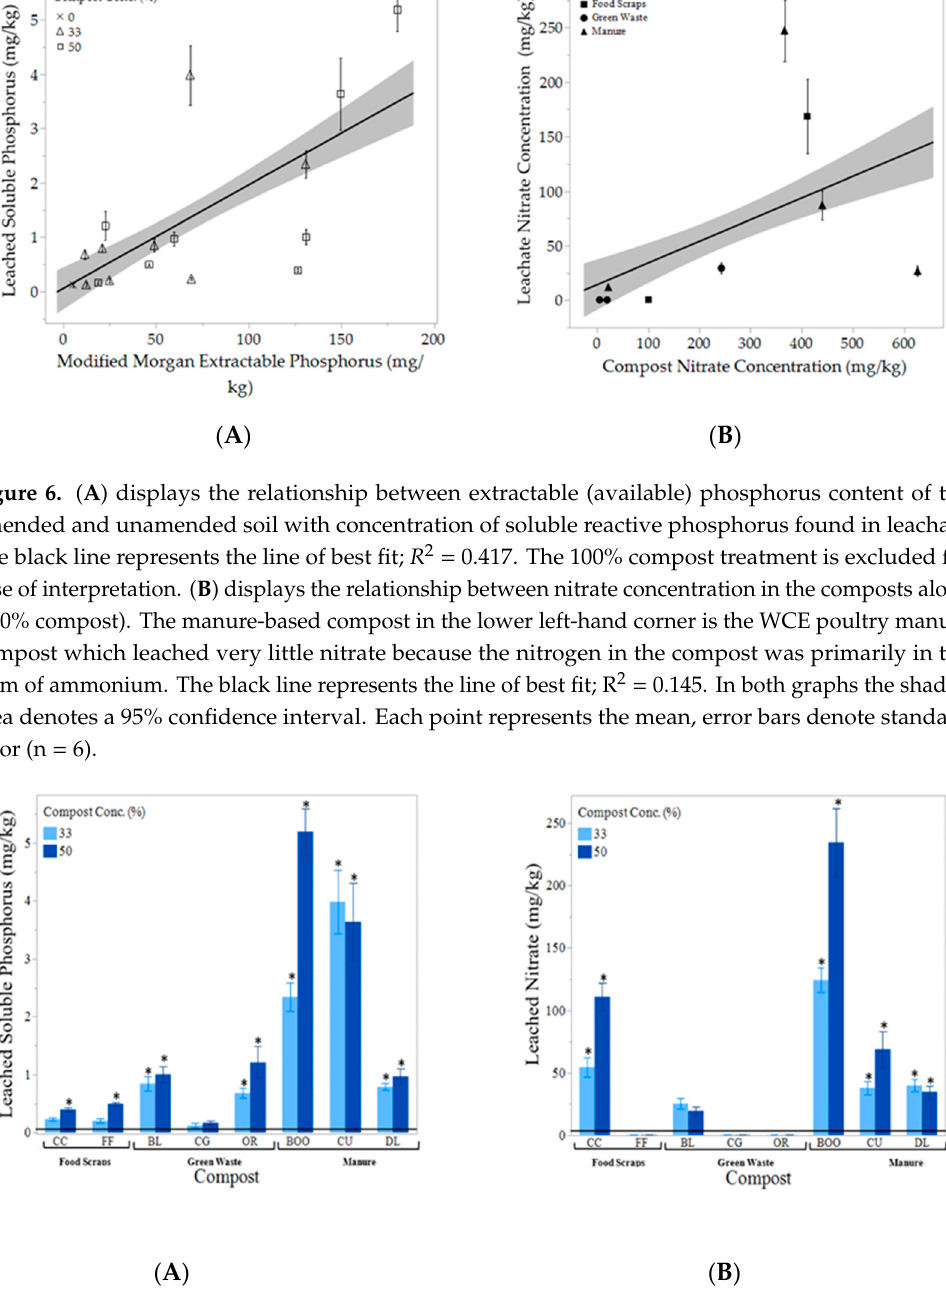
Figure 7. ( A ) shows mean soluble phosphorous found in leachate by compost type. Compost concentration of the growing media shown from light to dark (33% and 50%compost). The horizontal solid black line indicates the mean soluble phosphorus found in the leachate from the control (soil) equaling 0.122 mg/kg. ( B ) shows mean soluble Nitrate found in leachate by compost type. The horizontal solid black line indicates the mean nitrate found in the leachate from the control (soil) equaling 5.91 mg/kg. WCE compost and 100% compost concentration were excluded from both graphs. Error bars denote standard error (n = 6). Stars (*) indicate significant from the control ( α = 0.05).